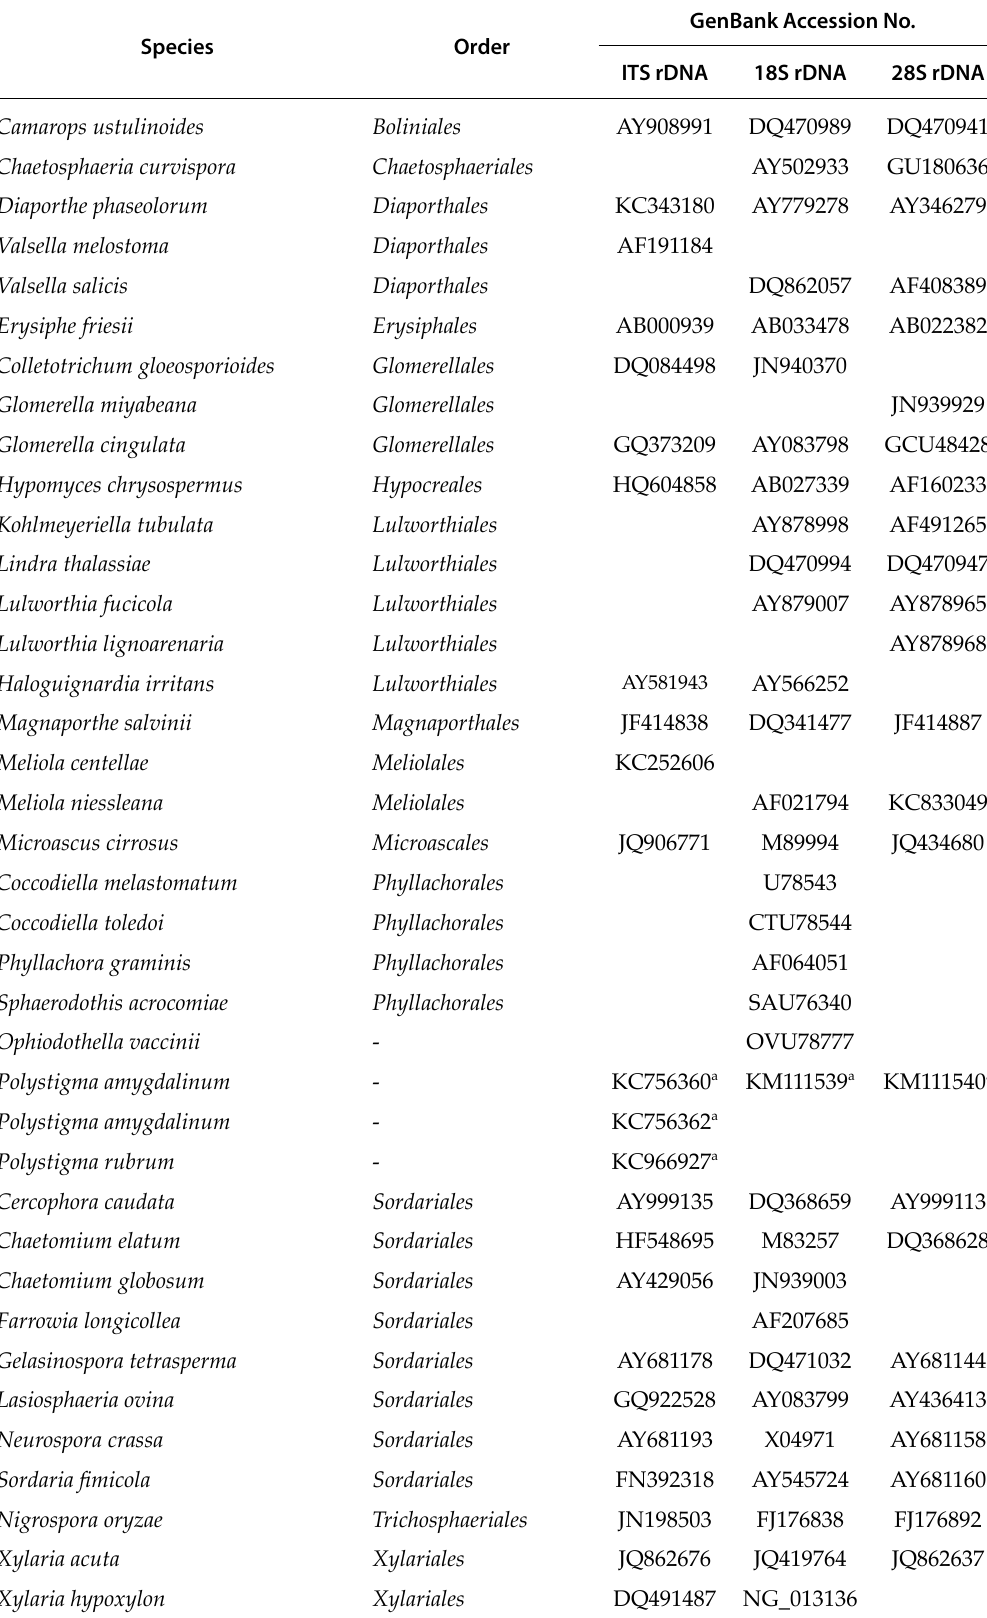
Table 1 . Fungal species included in phylogenetic analysis of this study. Species